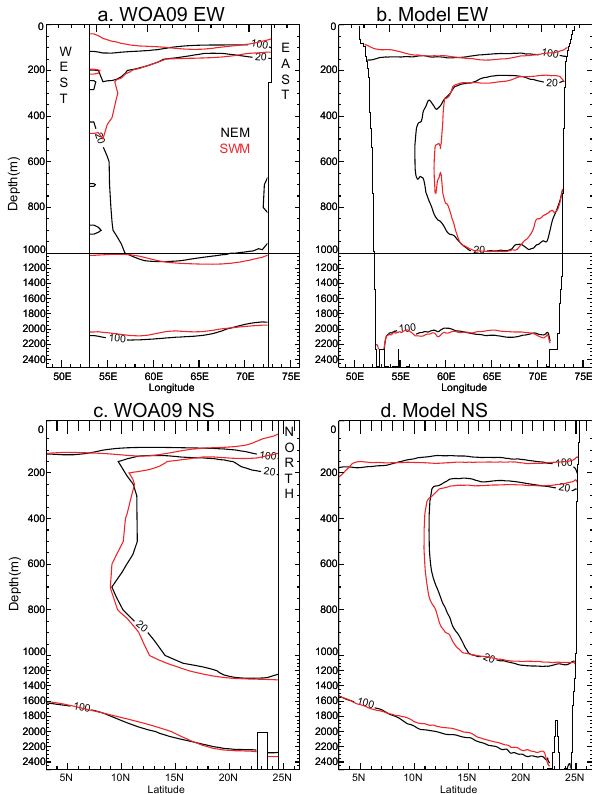
Fig. 5. Seasonal variability of the OMZ’s core (20µmolL − 1 con- tour) and of the 100µmolL − 1 isoline along the east–west (EW) and theeast-west(EW)andnorth-south(NS)sectionsindicatedonFig1h. Contoursaregivenforthewinter(NEM north–south (NS) sections indicated in Fig. 1h. Contours are given inblack)andsummer(SWMinred)monsoonsin: a,c)WOA09climatologyandb,d)themodel. for the winter (NEM in black) and summer (SWM in red) monsoons in (a) , (c) WOA09 climatology and (b) , (d) . the model